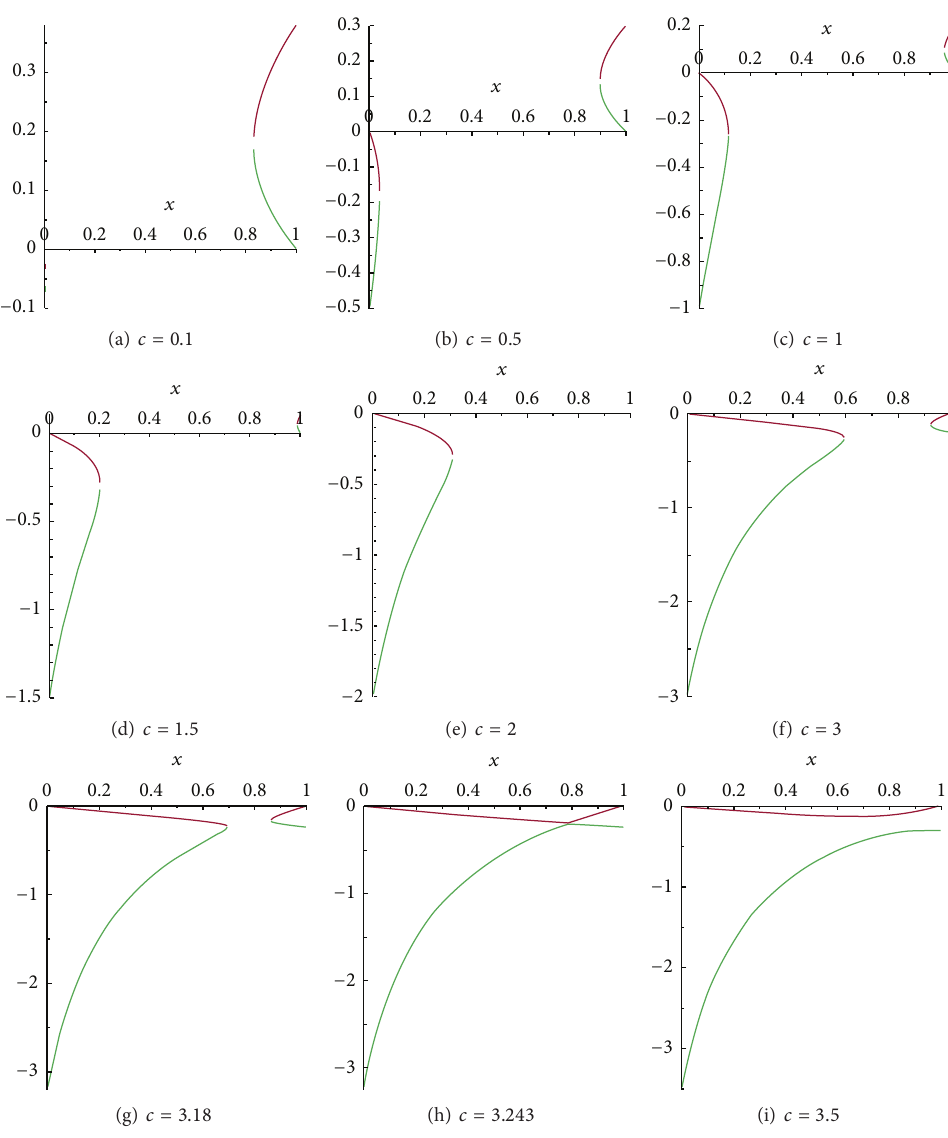
Figure 6: Behaviour of the two branches of the vertical nullclines of system (18) for fixed 𝑘 = 2 and 𝑐 > 0 : (a)–(g) for 0 < 𝑐 < 𝑀 𝑘 , (h) for 𝑐 > 𝑀 𝛽 = 2 𝑐 = 𝑀 𝑘 , and (i) for 𝑘 . Here